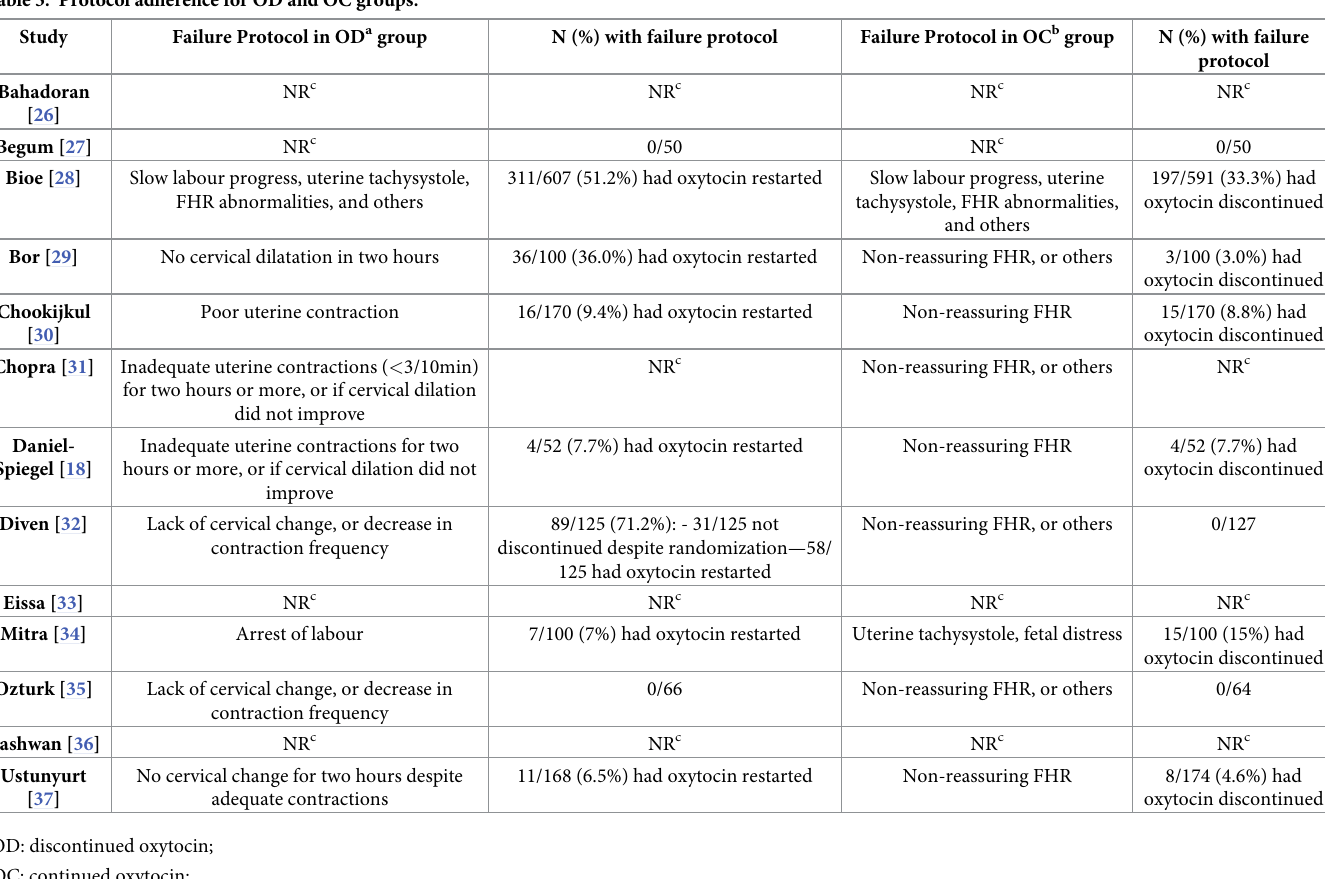
Table 3. Protocol adherence for OD and OC